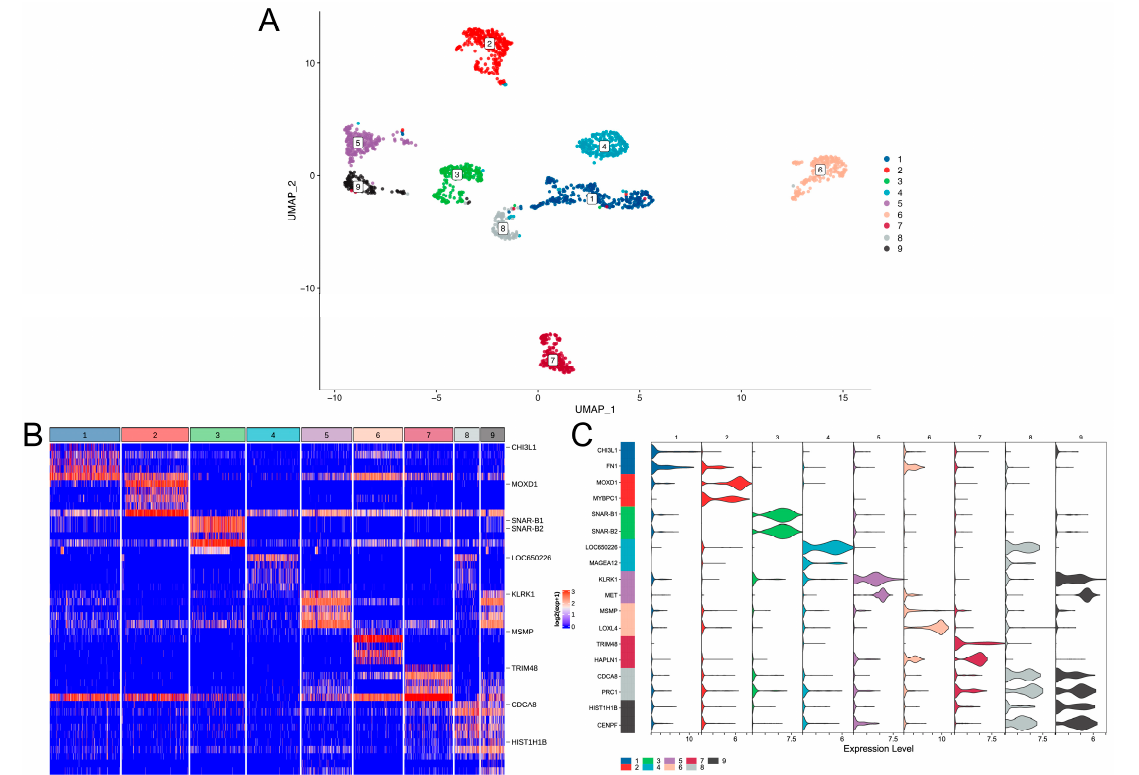
Figure 2. Unsupervised clustering of pediatric GBM cells. ( A ) UMap dimensionality reduction of clustering results. The X-axis and Y-axis represent the two dimensions of the UMap dimensionality reduction space. The points in the figure are cells, and all cells are colored separately according to the cluster labels. ( B ) The expression heat map of specific genes of cell clusters. Only the top five genes with significant differences in log2FC of each cell cluster are shown, and the gene name is annotated for the first gene. The upper color bar corresponds to each cell cluster. ( C ) Violin diagram of cell cluster-specific gene expression. The upper numeric label and the color bar on the left represent each cell cluster. The X-axis is the expression value, and the Y-axis is the gene. Only the top two genes with significant differences in log2FC of each cell cluster are